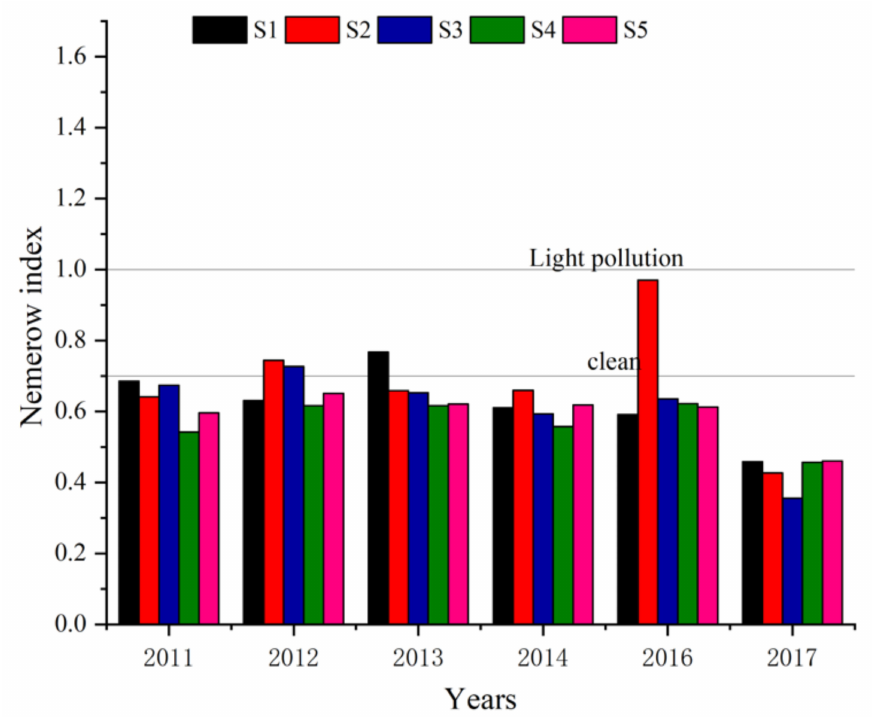
Figure 4. The Nemerow pollution index of HMs in different years.